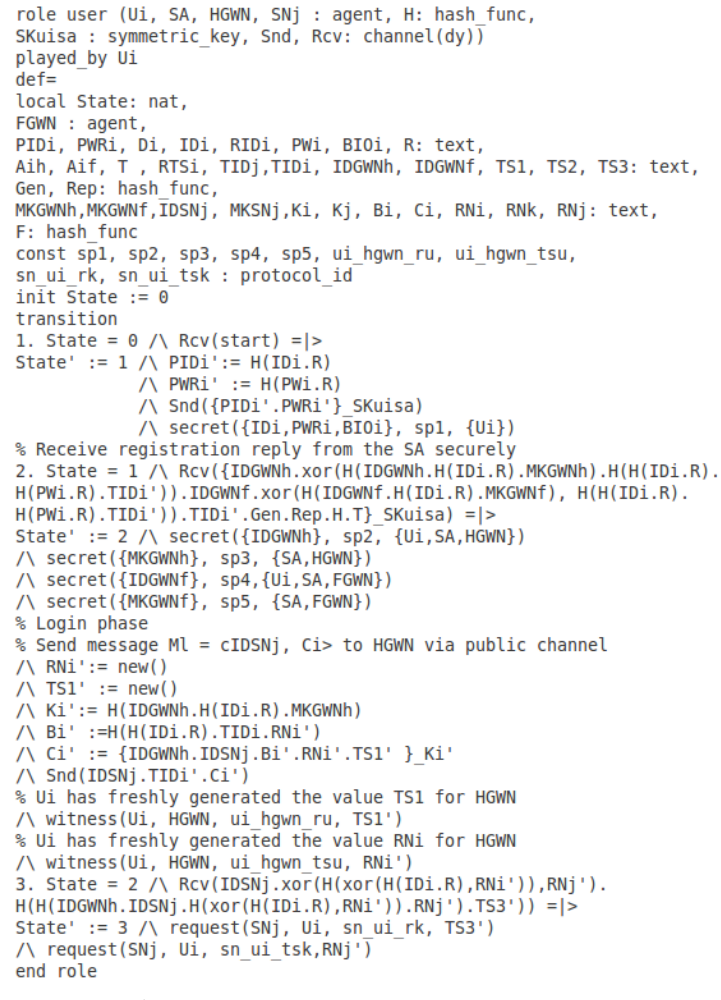
Figure 11. role in